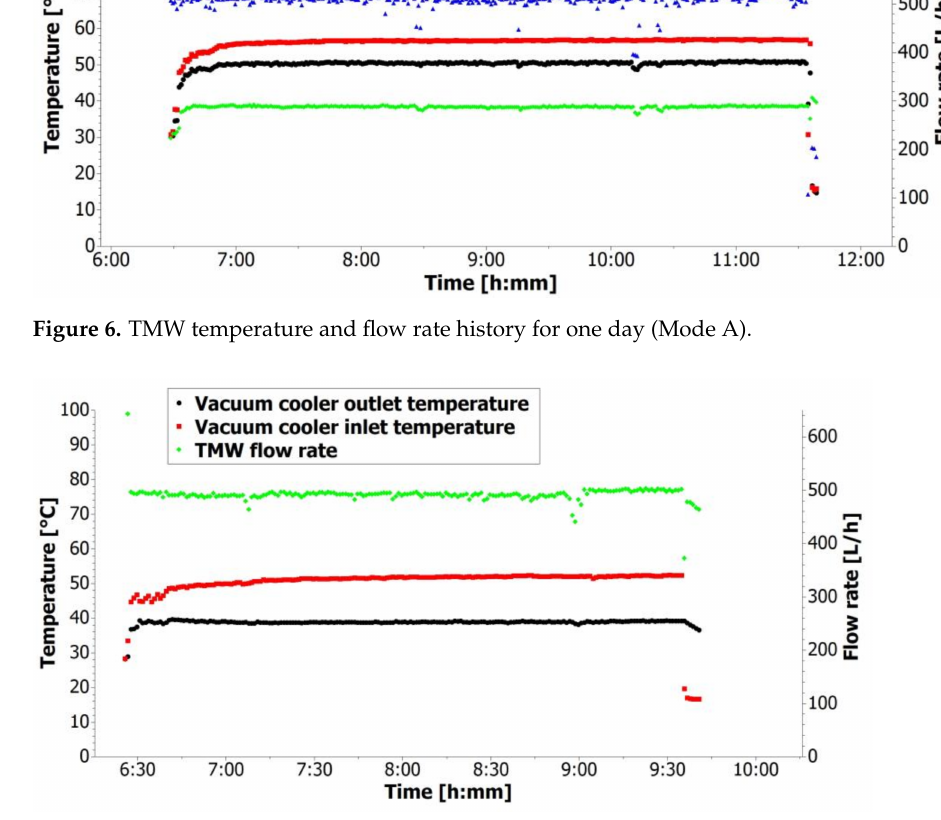
Figure 7. TMW temperature and flow rate history for one day (Mode B).